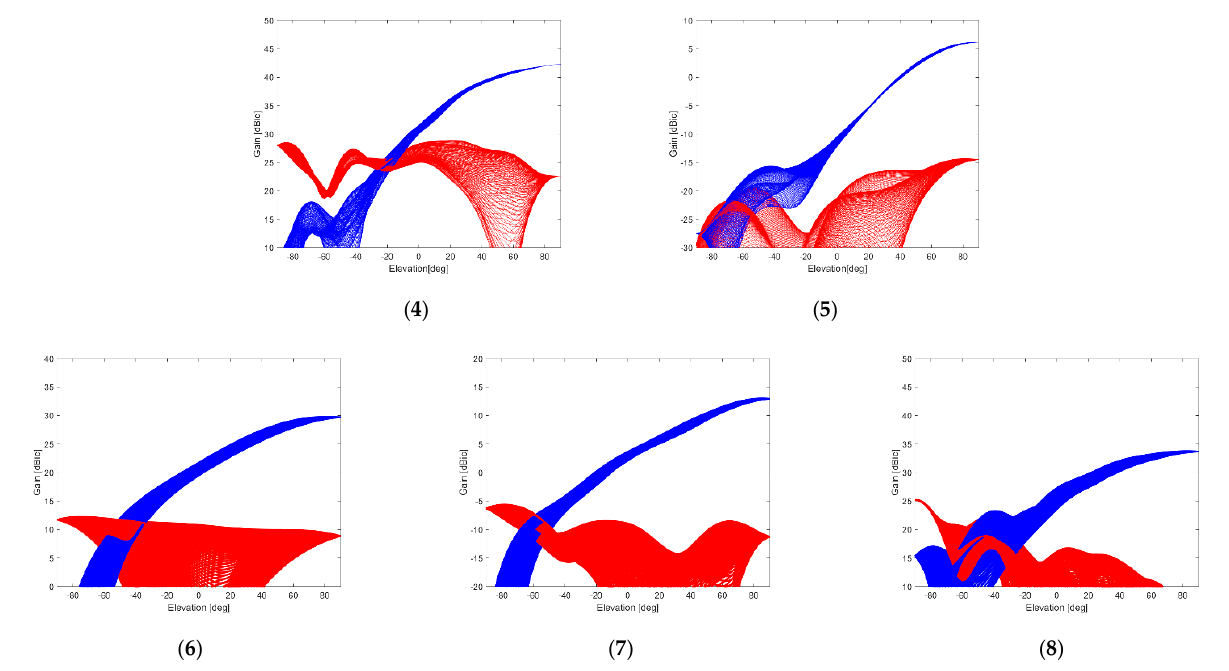
Figure A2. Gain in dBic (RHCP in blue, LHCP in red; different lines represent different azimuth values with a resolution of 2 deg) at L5/E5a central frequency of the antennas measured at DLR; from left to right, from top to bottom: ( 1 ) Leica AR25 R4; ( 2 ) Novatel GNSS-750; ( 3 ) Javad RingAnt-DM; ( 4 ) Space Engineering GalExpAnt; ( 5 ) DLR internal design; ( 6 ) Novatel 703-GGG; ( 7 ) Navxperience Nav3G+C; ( 8 ) Tallysmann VSE6028 VeroStar. The plots for the different antennas exhibit always a gain range of 40 dB along the y -axis, though having different maximum gain values. This is due to the fact that some antennas are passive and some are active with different LNA gains.